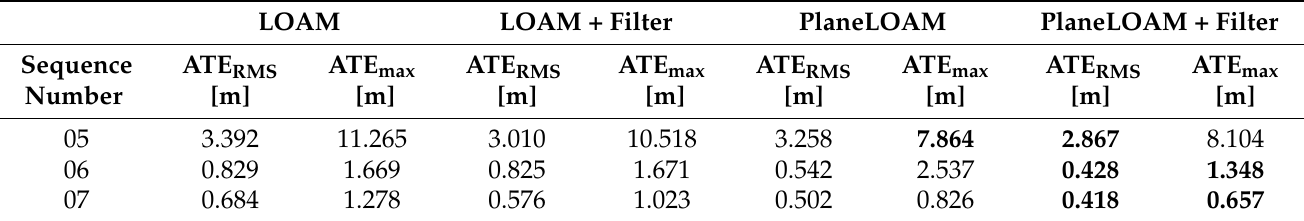
Table 1. Comparison of ATE errors for the three KITTI sequences used in evaluation—best results shown in bold. LOAM LOAM + Filter PlaneLOAM PlaneLOAM + Filter